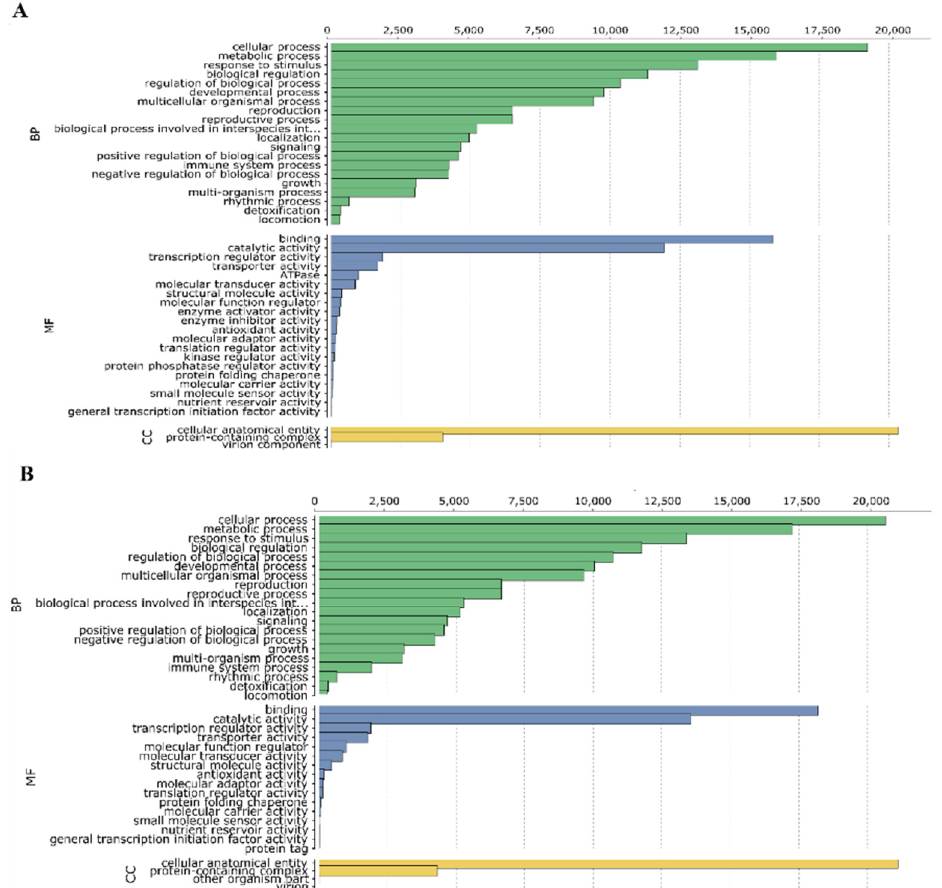
Figure 5. Gene ontology (GO) functional classification of tree tomato A21 ( A ) and A23 ( B ) transcriptomes. Histograms of transcripts annotated to specific GO categories; BP = biological process, MF = molecular functions and CC = cellular components and are represented by green, blue, and yellow bars, respectively.